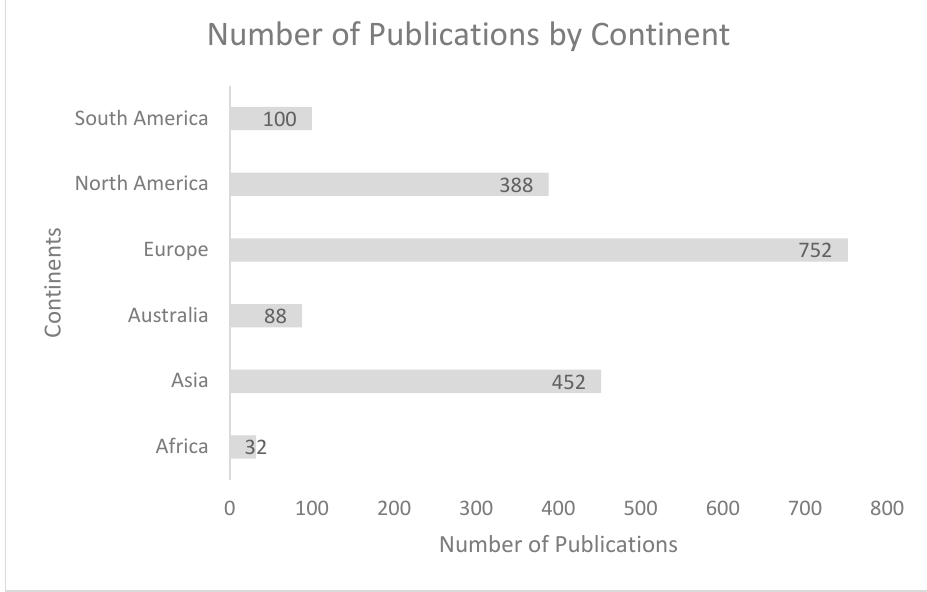
Figure 1. Showing number of forest-related UAS publications by continent.